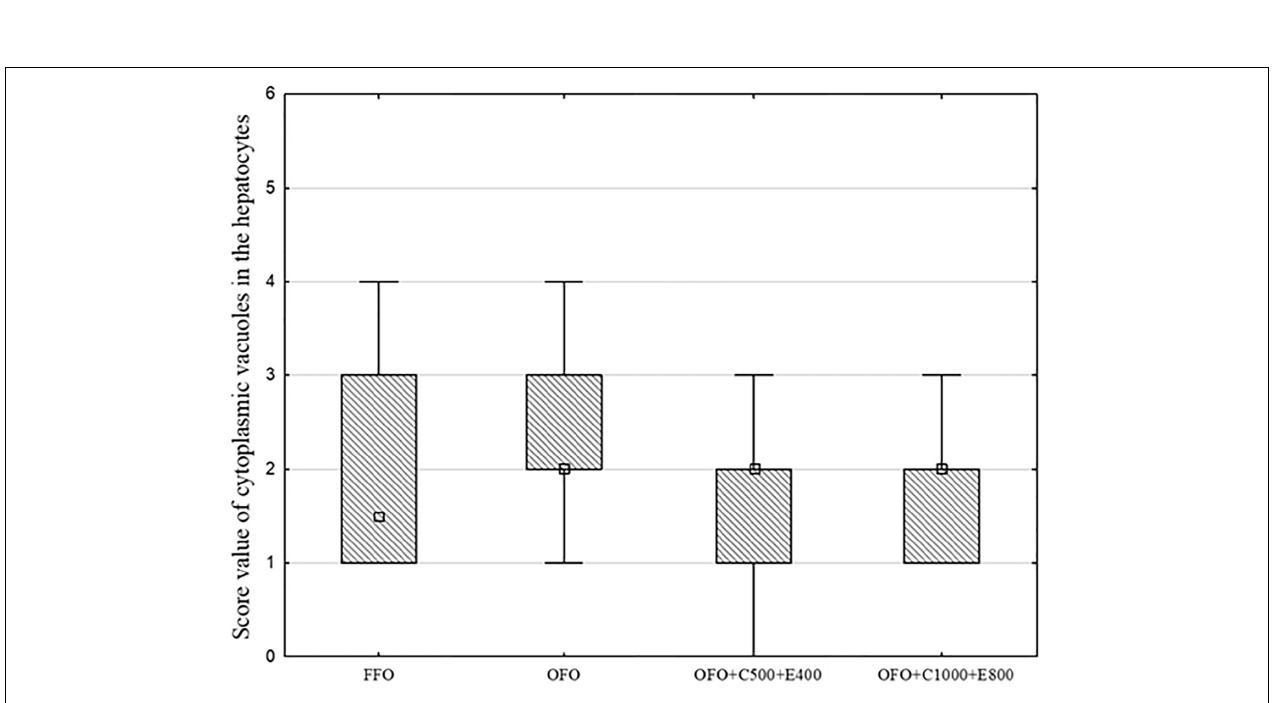
FIGURE 3 | Box Plot of vacuoles in the cytoplasm of liver of rainbow trout fed fresh fish oil diet (FFO diet), oxidized fish oil containing diet (OFO diet), OFO diet supplemented with 500 mg kg − 1 VC and 400 mg kg − 1 VE (OFO+C500+E400) or 1,000 mg kg − 1 VC and 800 mg kg − 1 VE (OFO+C1000+E800). The absence of superscript letters indicates no significant differences among treatments ( P > 0.05), n = 5–7.